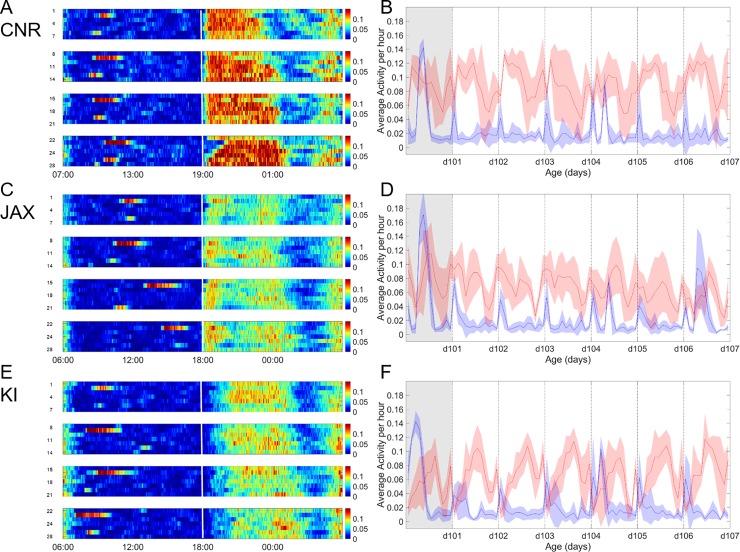
Day and night time activity at CNR, JAX and KI.A, C, E. Heat maps showing average global activity (all 12 electrodes) recorded from 5 cages with 5 female C57BL/6J in each cage, during 4 consecutive weeks (day 1 through 28 on the ordinate) at CNR (A), JAX (C) and KI (E); activity coded in color according to scale on the right side of the panels A, C and D. Each panel is 1 week; with days as rows on the ordinate and time h on the abscissa. To the left is day break with lights-on and white vertical line indicates transition to night time with lights-off. Cages were subjected to daily check-up which are done without removing the cage from the rack. Two more intrusive procedures are conducted weekly with a cage-change on Thursday and a second handling for weighing with health assessment on Monday; both procedures require cage removal from the rack, transferring to a changing station, opening of cage and removing animals from the cage; i.e. manual handling of each animal. The general day and night rhythm of activity alterations as well as the impact of procedures replicates well across sites. A main difference between sites was a generally higher level of activity (p<0.001) after at CNR (A) compared with both JAX (C) and KI (D) and also a slower increase in activity at lights-off at KI (cf. A-C-E and see also Figs 5 and 9). Note also that the response to lights-on starts prior to the event and last for an hour following lights-on while the response to lights-off occurs after darkness. Use of 30 minutes of dawn and dusk at light-on/off, i.e. slow light change transition, did not significantly alter the responses (not shown). B, D, F Actigrams showing global (all 12 electrodes) average activity per hour of the cages shown as heat maps in A, C and E (day 15 to 22). Each bin indicated by dotted vertical lines display the night time (12 hrs. of lights off) activity superimposed on day time activity (12 hrs. of lights on). The grey-shaded bin is day of cage-change. Abscissa denotes age of animals (in days) and ordinate average activity. The blue trace is average per h (of activity per minute) daytime activity (each bin starts at lights-on until lights-off) and shaded blue areas denotes the standard deviation. The red trace is the corresponding night time activity (each bin starts at lights-off until lights-on) i.e. with a 12 hrs. phase shift to the red traces, with the standard deviation indicated as shaded red area. As evident from the heat map and plots there is a significant difference between activity during day and night time at There is also a difference in activity between sites day and night (p<0.001).